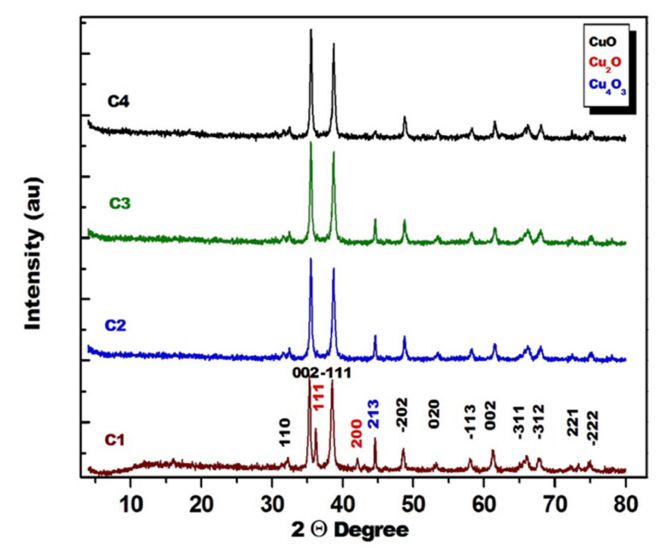
Figure 1. The C1, C2, C3, and C4 samples’ X-ray Diffraction (XRD) patterns. Table 2. Miller indices, two theta values (observed and calculated), and the discrepancies between the two theta values for various